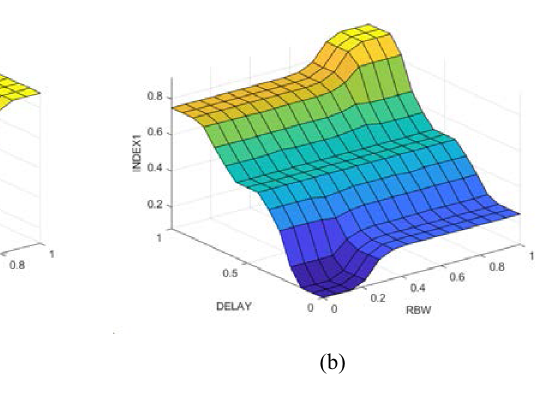
Fig. 5. Key Variable Surface Plot.